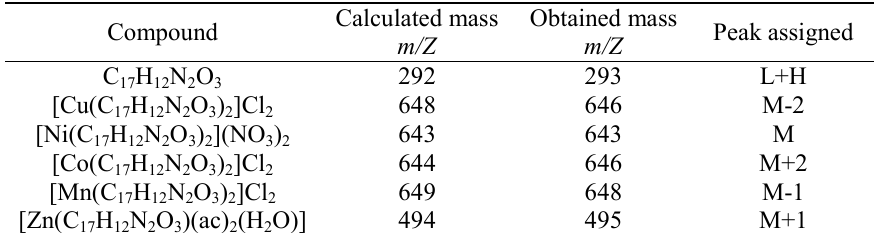
Table 3. Mass spectral data of schiff base ligand and its metal